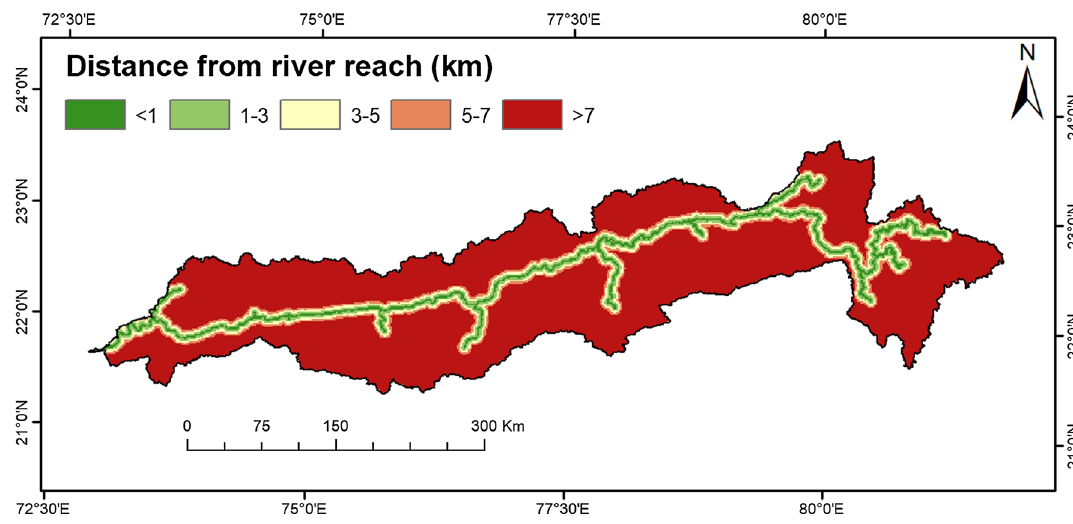
Fig. 7 Spatial distribution of distance from river reach over Narmada River